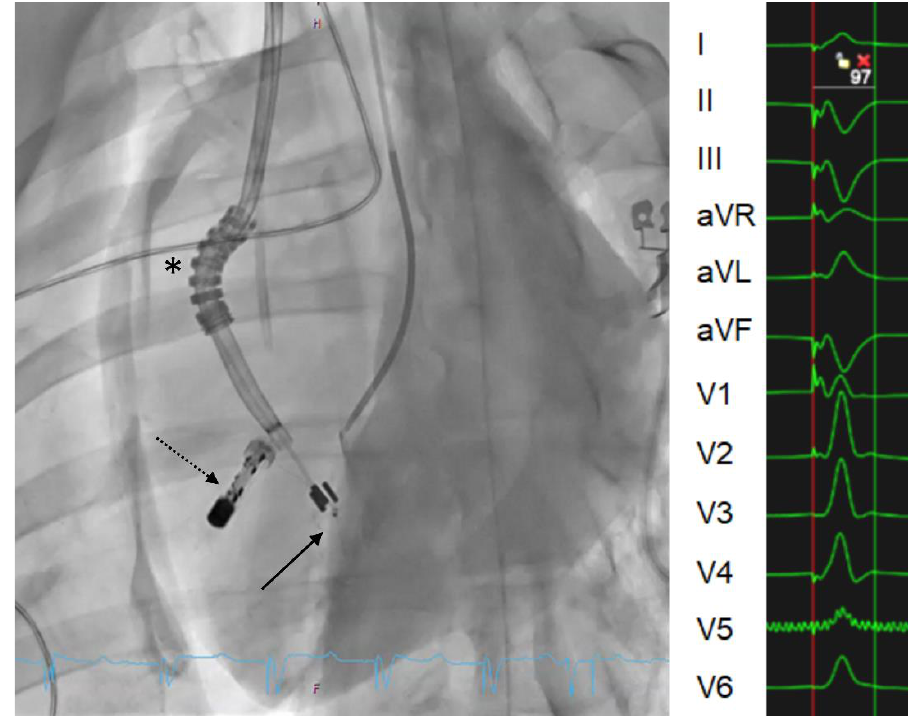
Figure 5. Implantation of a leadless CSP PM in a domestic pig. The steerable implantation catheter (asterisk) allows positioning the stimulation electrode towards the interventricular septum (solid arrow). The main body of the leadless PM is implanted in an apical position (dotted arrow). The corresponding ECG with a simulated QRS duration of <100 ms is shown on the right.